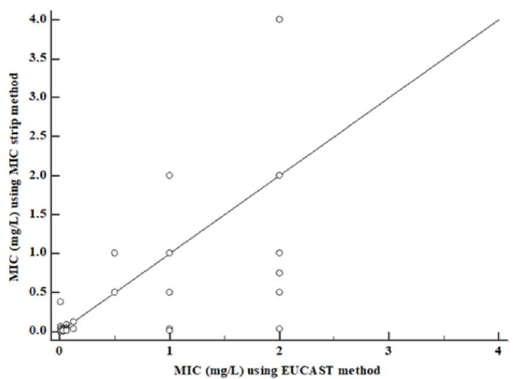
Figure 2. Essential agreement between the EUCAST reference method and MIC strips.